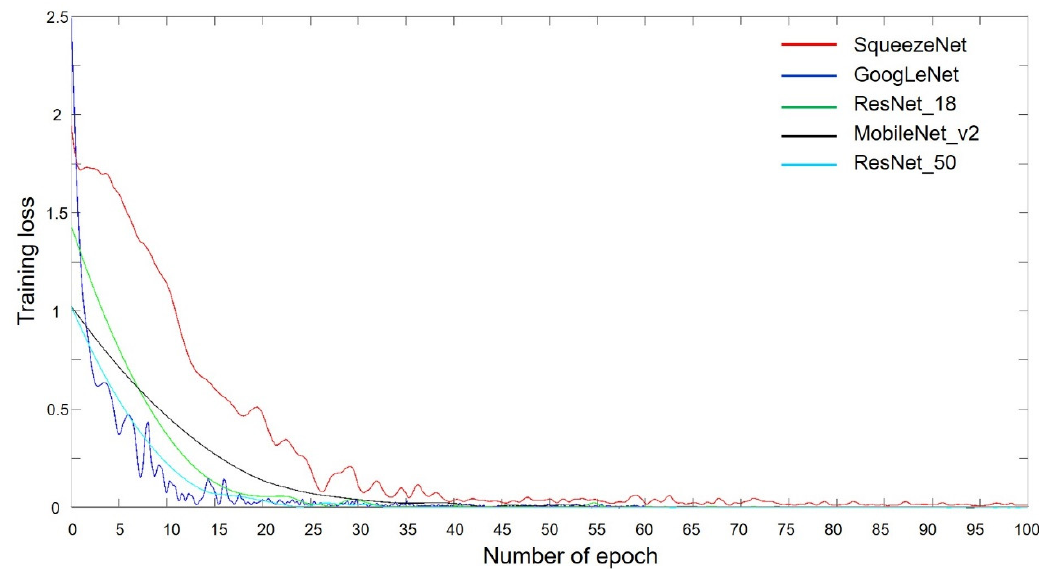
Figure 5. Training progress of the five pretrained networks with respect to the number of epochs.